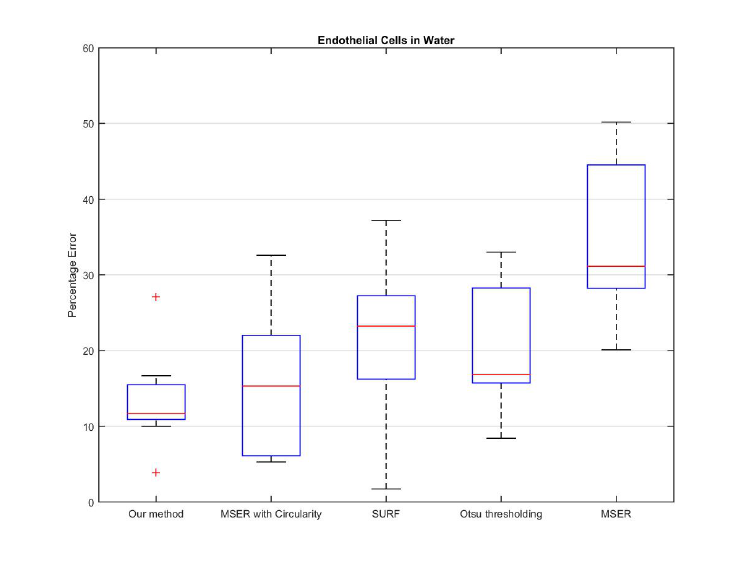
Figure 24. Performance comparison of different perception methods for human endothelial cells and silica beads in water.